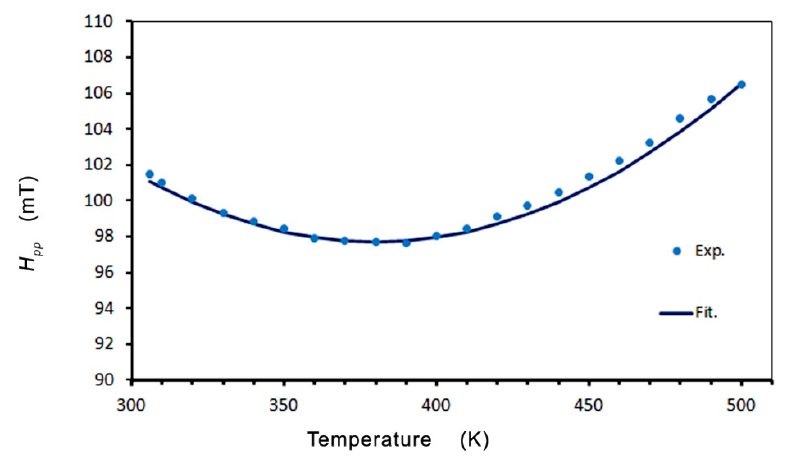
Figure 6. Temperature dependence of the resonance linewidth H pp .